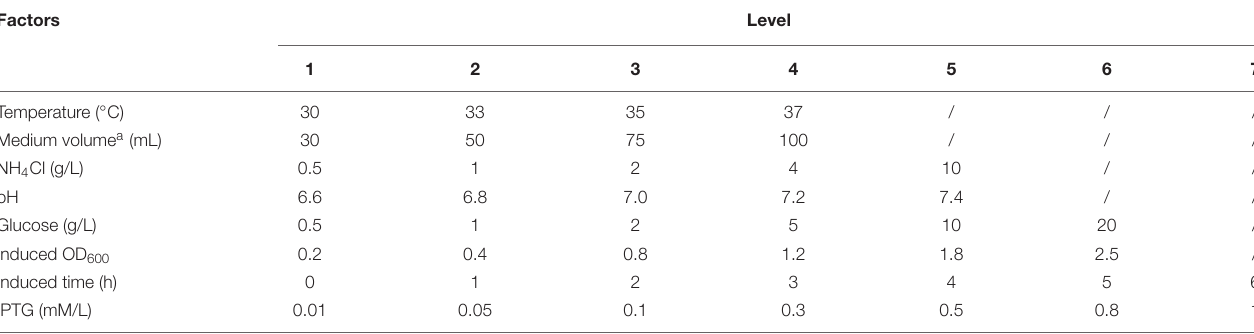
TABLE 1 | Optimization of the fermentation parameters for rhaFGF 135 .